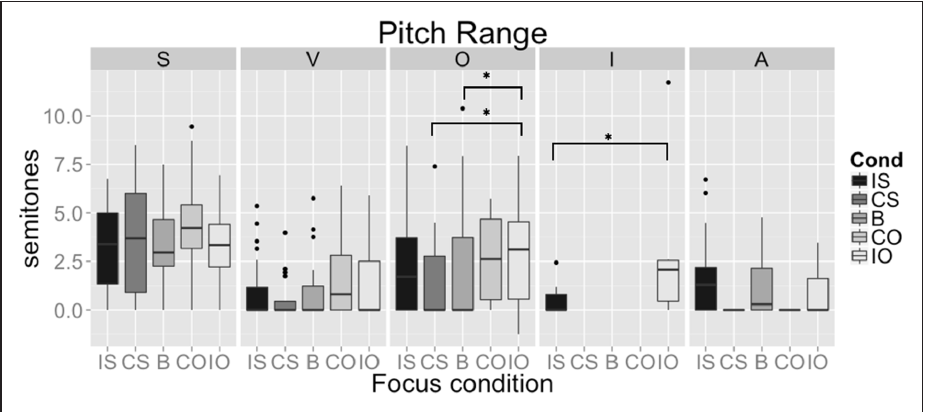
Figure 10: Pitch range on each content word (subjects, verbs, objects, indirect objects and adjuncts) in the following focus conditions: Informational focus (IS), contrastive focus (CS), broad focus (B) or non-focused in contexts of contrastive object focus (CO) and informational object focus